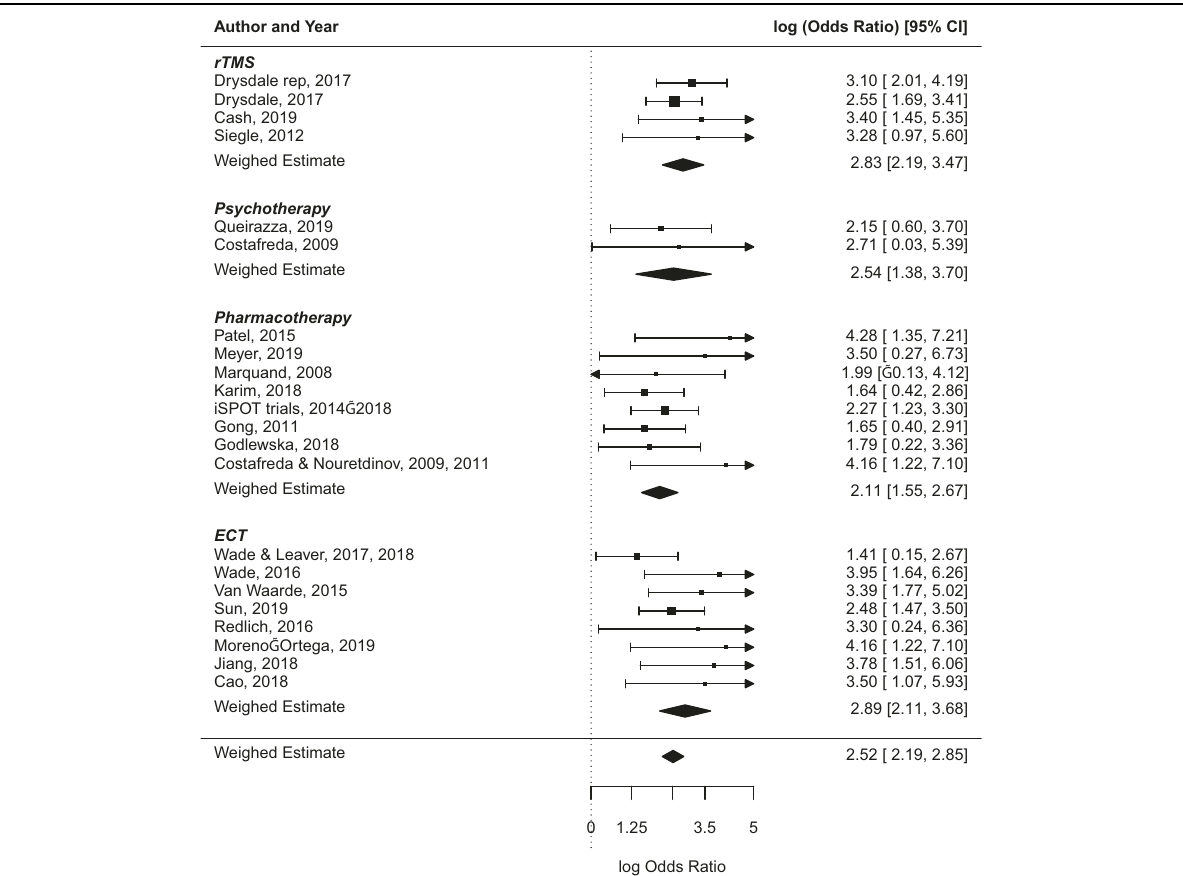
Fig. 3 Univariate random-effect forest plot of natural logarithm of diagnostic odds ratios. Summary estimates for odds ratios are computed assuming normal distribution. CI con fi dence interval, rTMS repetitive transcranial magnetic stimulation, ECT electroconvulsive